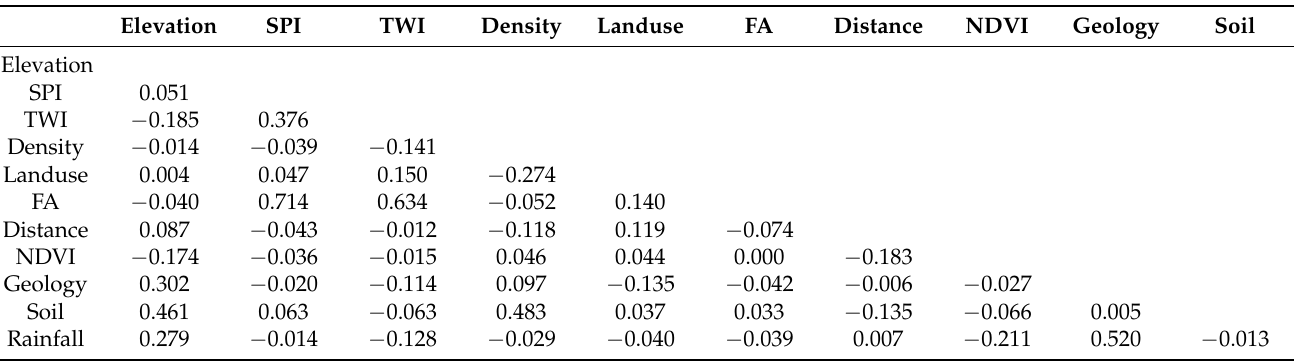
Table 2. Multi-collinearity between